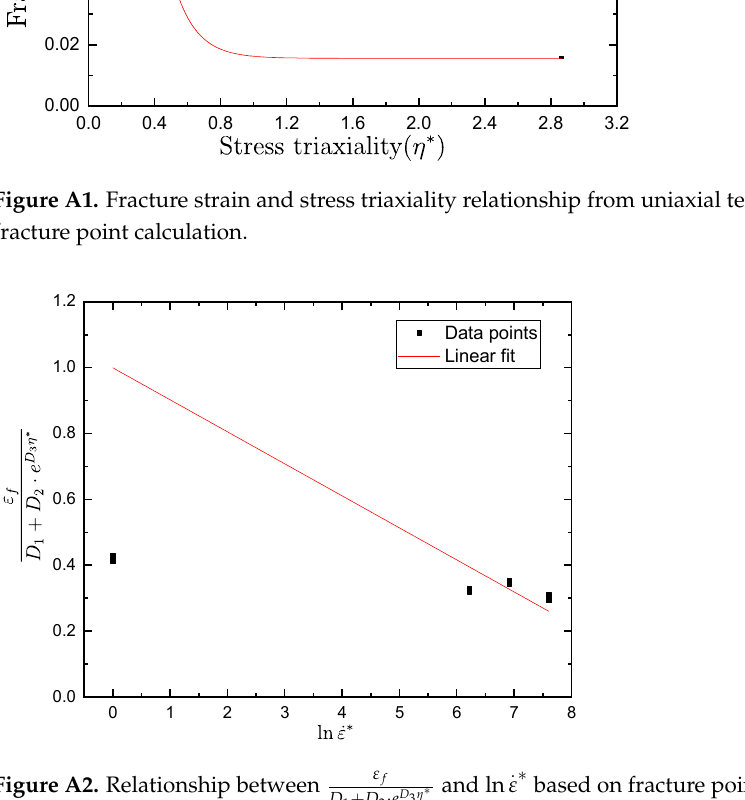
Figure A2. Relationship between ε f